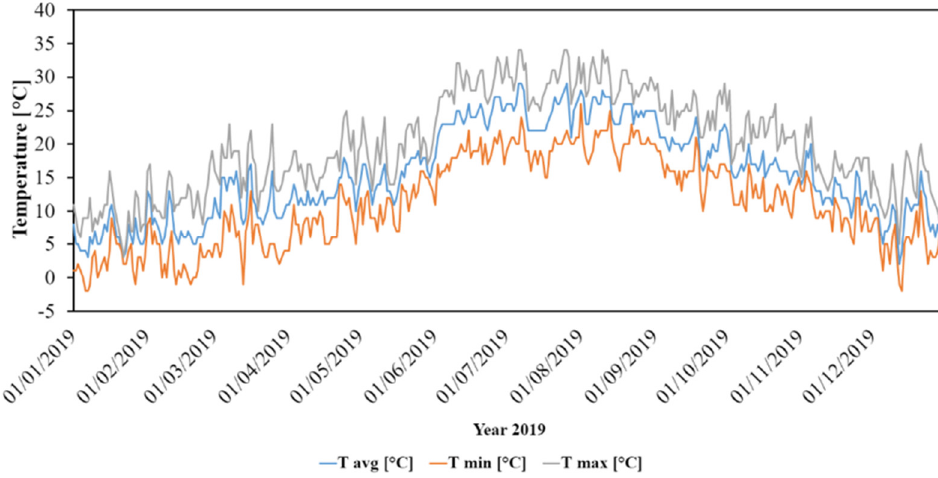
Figure 2. Temperature profiles recorded in Osimo (year 2019).